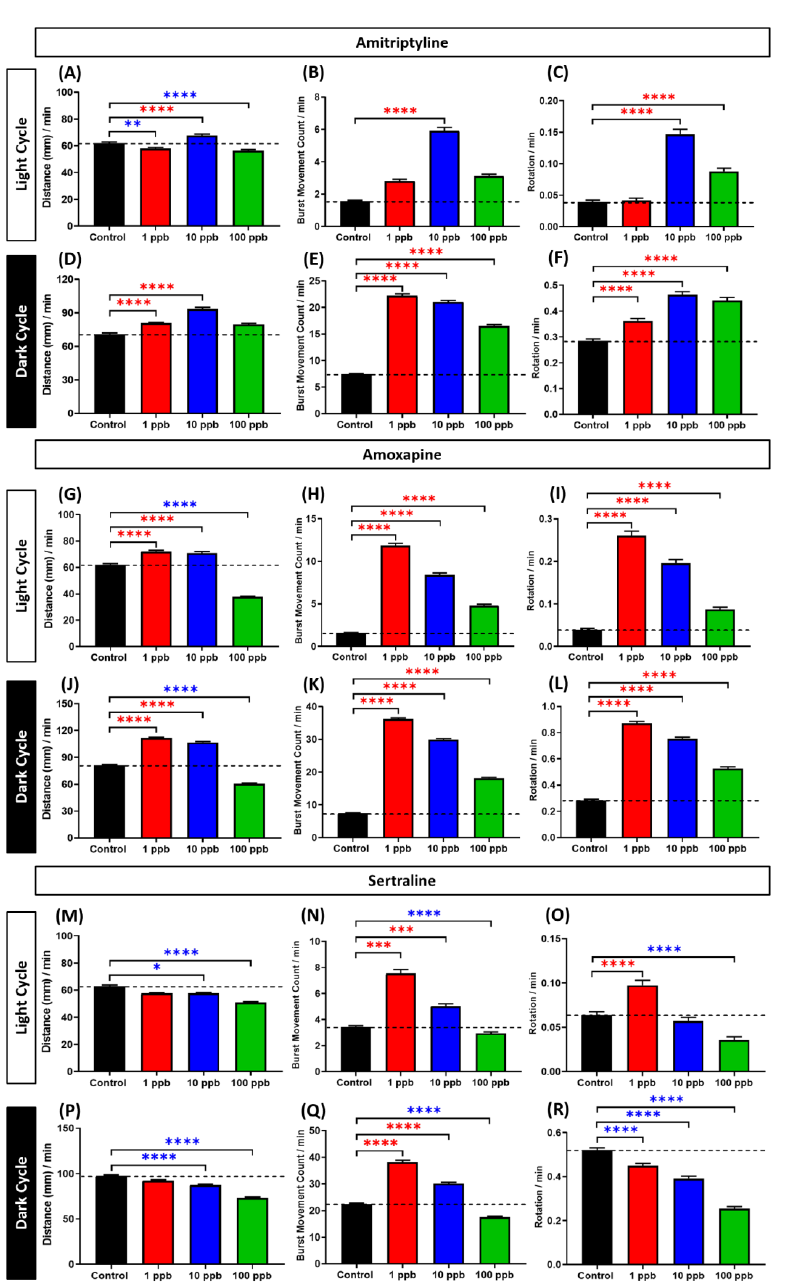
Figure 4. Comparison of ( A , D , G , J , M , P ) average total distance traveled, ( B , E , H , K , N , Q ) average burst movement, and ( C , F , I , L , O , R ) rotation count of zebrafish larvae after 1-day exposure of 0 (control), 1, 10, and 100 ppb of AMY, AMO, and SRT during both light and dark cycles. The statistical different significances between each treated group were statistically compared to the control group by Kruskal–Wallis test continued with Dunn’s multiple comparisons test. All of the data are presented as mean ± SEM. Blue asterisk indicates a significant decrease in the value and red asterisk indicates a significant increase in the value in comparison to the control group ( n = 167 for control, n = 96 for each concentration of tested antidepressants group, except 10 ppb AMY group ( n = 95), * p < 0.05, ** p < 0.01, *** p < 0.001, **** p < 0.0001). The details of these Kruskal–Wallis tests can be found in Table